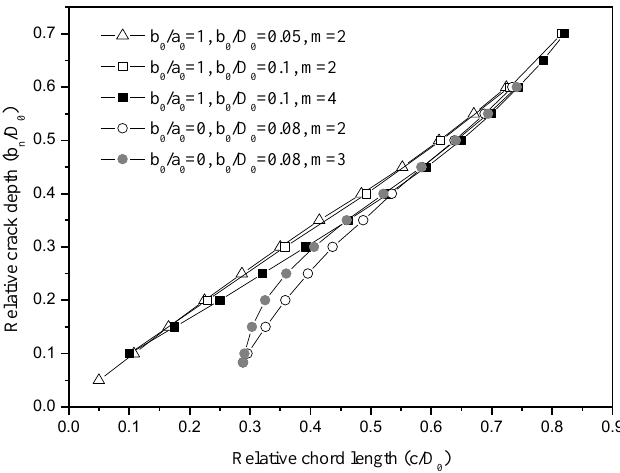
Figure 10. Relative crack depth vs. relative chord length with different initial parameters.